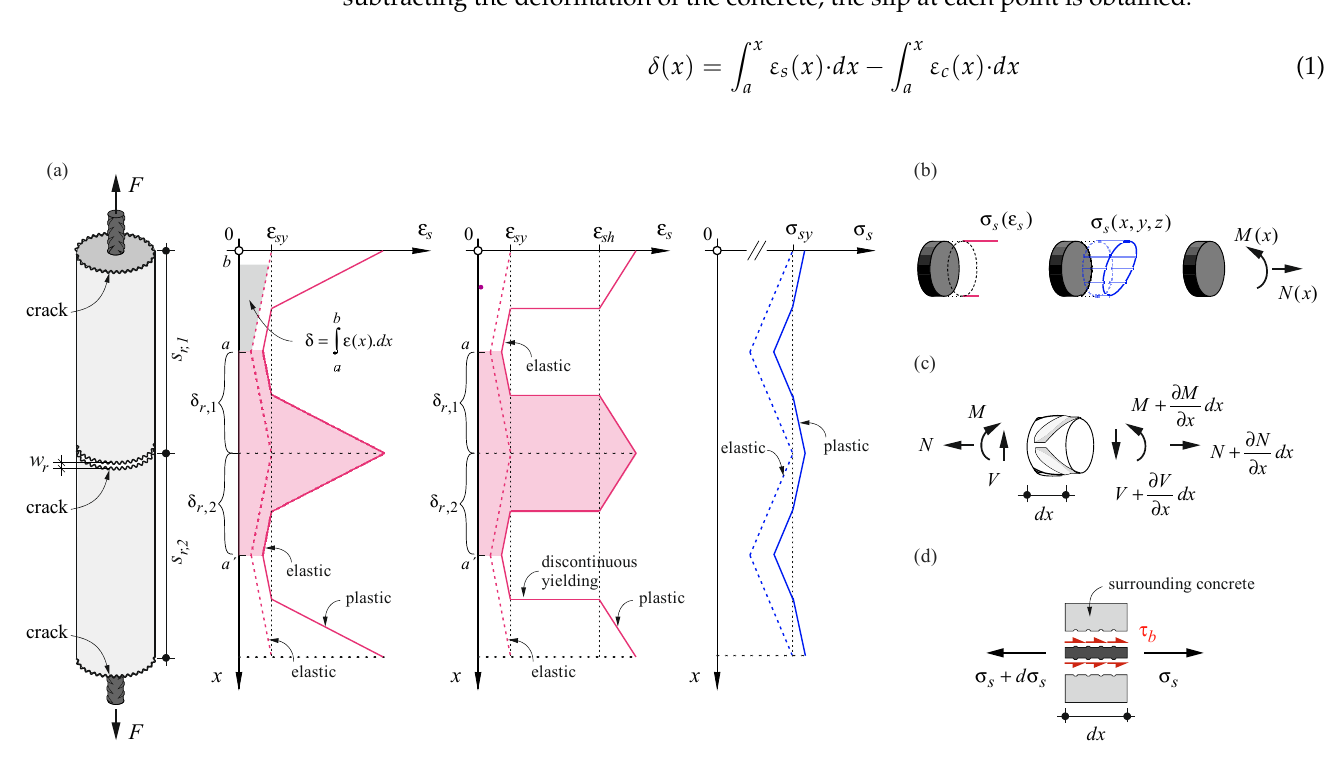
Figure 5. Structurally relevant results obtained from DFOS strain measurements on an embedded reinforcing steel bar: ( a ) simplified steel strain distribution in an RC tie for CW and QST steel, respectively, and the corresponding stress distribution; ( b ) from local stresses to a stress distribution and acting forces on a cross-section; ( c ) equilibrium on a differential steel element; and ( d ) local bond shear stresses based on equilibrium on a differential steel element.